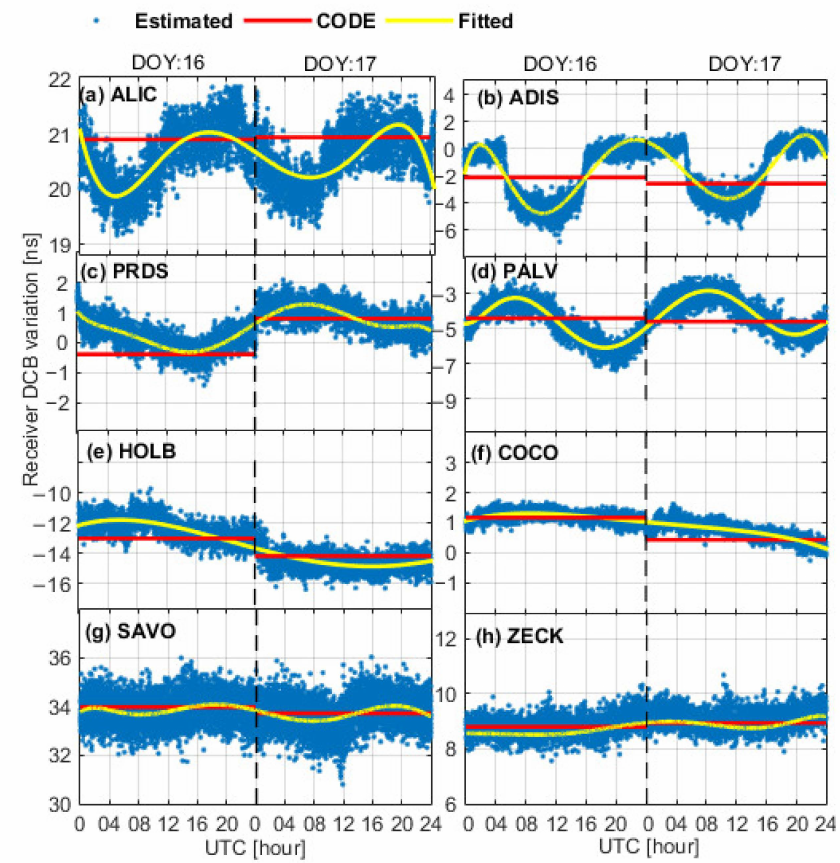
Figure 10. Intraday variation characteristics of receiver DCBs spanning consecutive days. The blue scattered dots represent the epoch-wise estimates of the receiver DCBs, the yellow lines represent fits to these values, and the red solid lines represent the CODE DCB